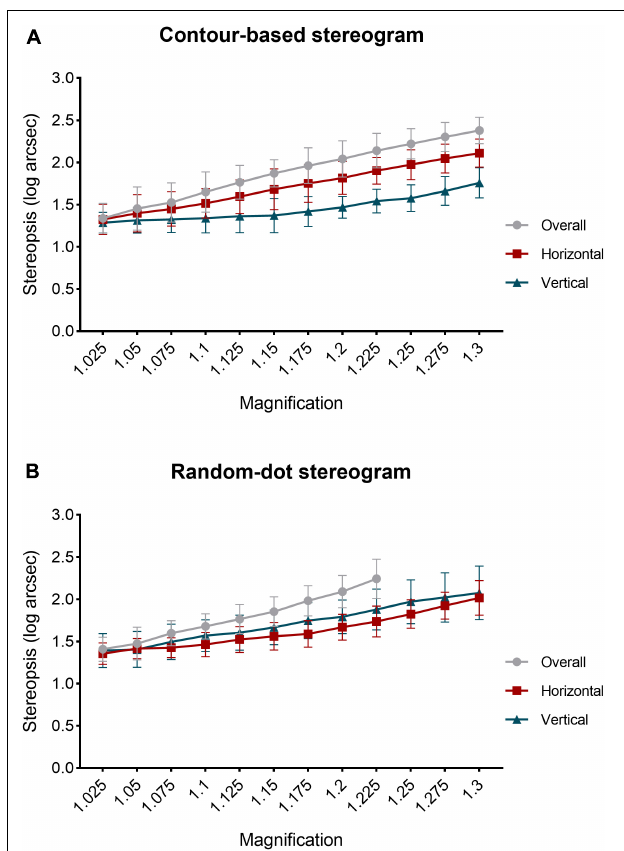
FIGURE 6 | Relationship between induced aniseikonia and stereopsis values (log arcsec). (A) Contour-based stereograms. (B) Random-dot-based stereograms. Datapoints and error bars represent mean with standard deviation (SD). The final three data points of overall magnification curve in the random-dot stereogram image were not plotted because some participants failed to pass the test when magnification increased to 25, 27.5, and